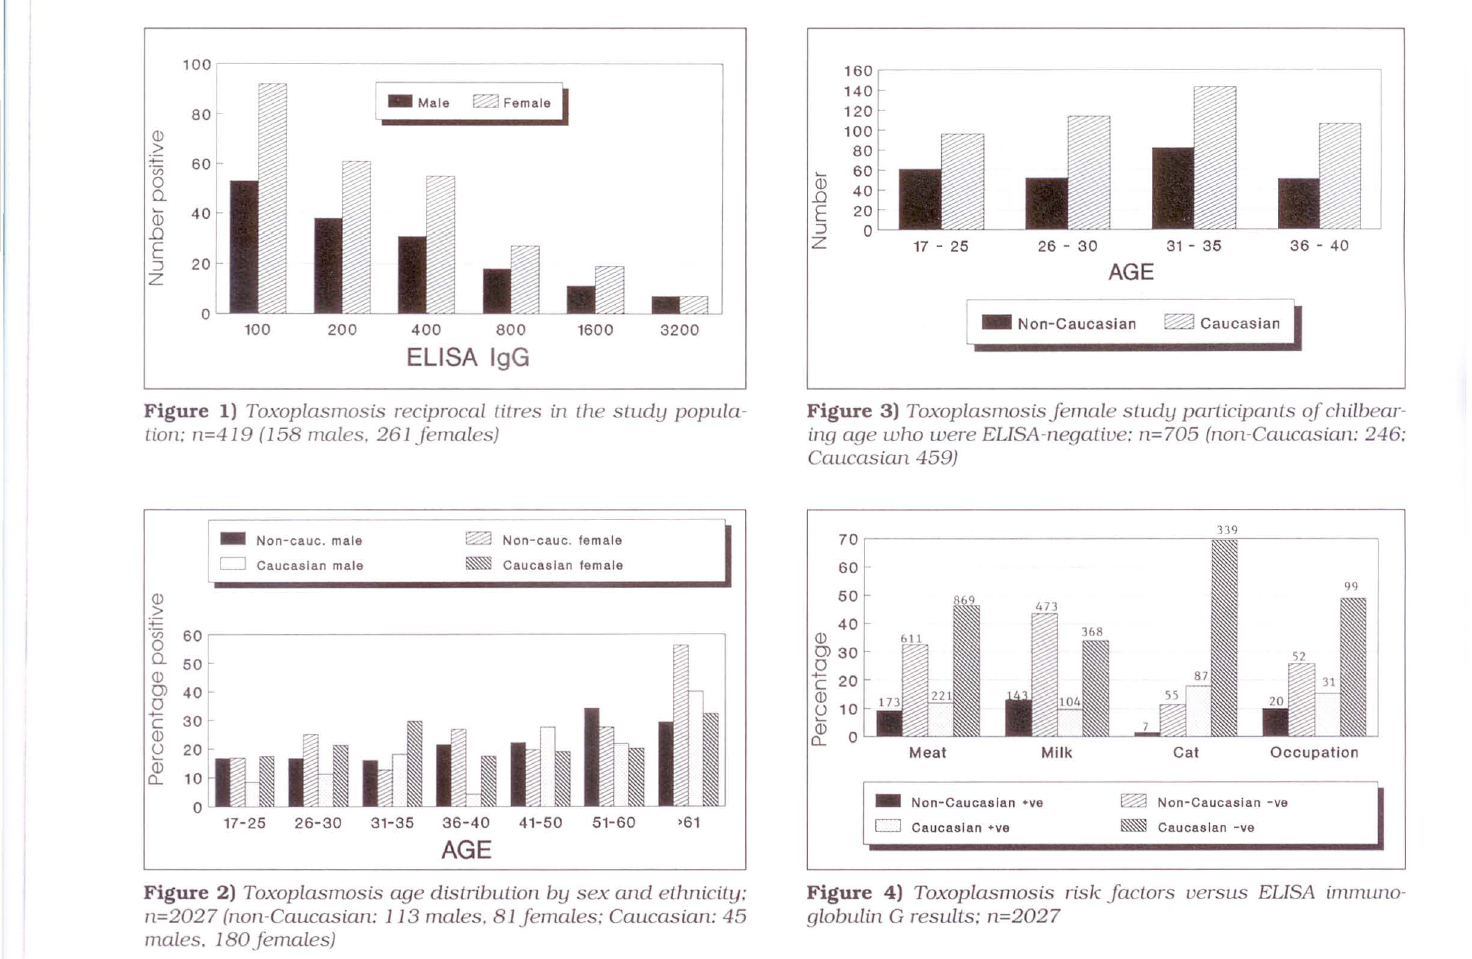
Figure 2) Toxoplasmosis age distribution by sex and eLhnicity: n=2027 (non-Caucasian: 113 males. 81 f emales: Caucasian: 45 males. 180females)